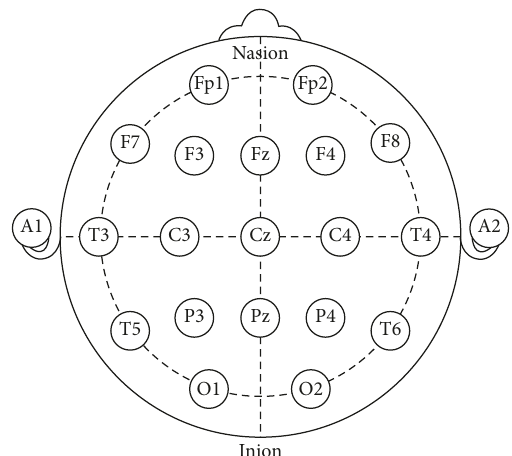
Figure 1: The international 10-20